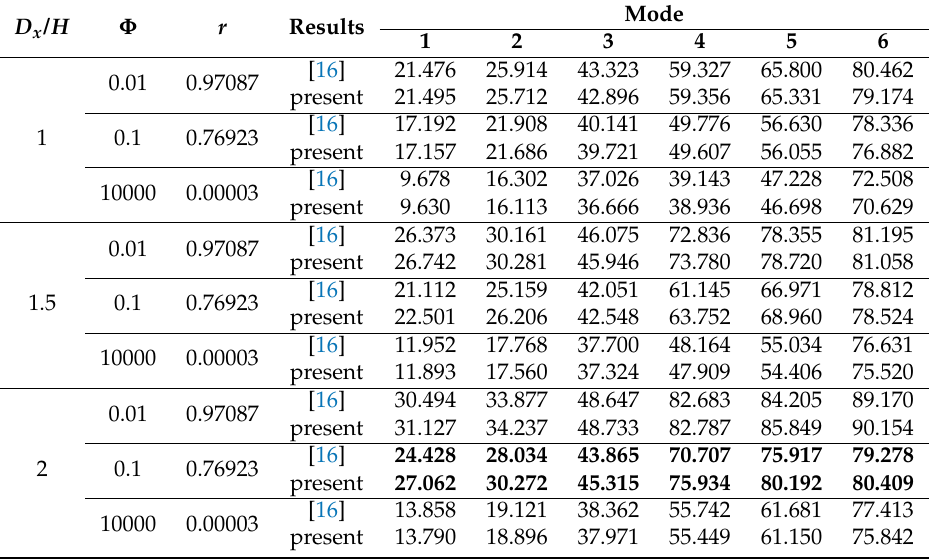
Table 3. First six frequency parameters Ω = ω a 2 stiffness and different rotational fixity factors ( D y / H = 1, ν = 0.3, and a / b =